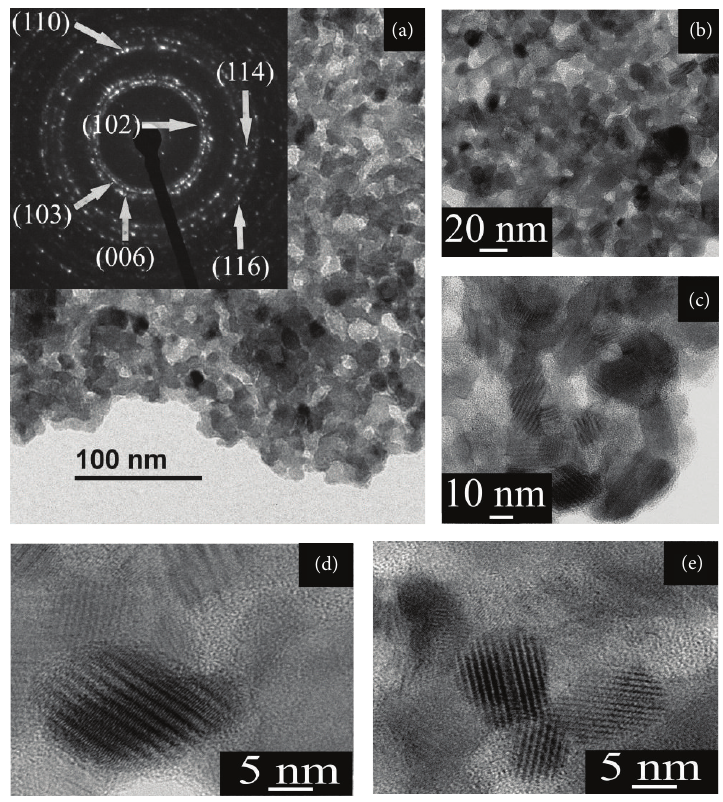
Figure 1: HRTEM images of nanodisks of CuS. (a) Low magnification HRTEM image of representative copper sulfide nanocrystals (inset: corresponding SAED pattern); (b), (c), (d), and (e) higher magnification images of the portion of the CuS with columns of nanodisks with the edges oriented perpendicular to the substrate.